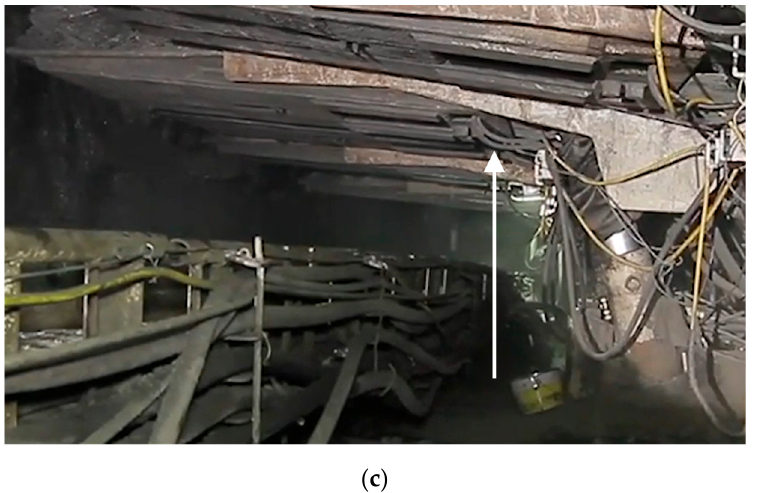
Figure 2. Work cycle for the powered roof-support section: ( a ) withdrawing the powered roof-support section, ( b ) moving the powered roof-support section to a new location, ( c ) spragging the powered roof-support section.